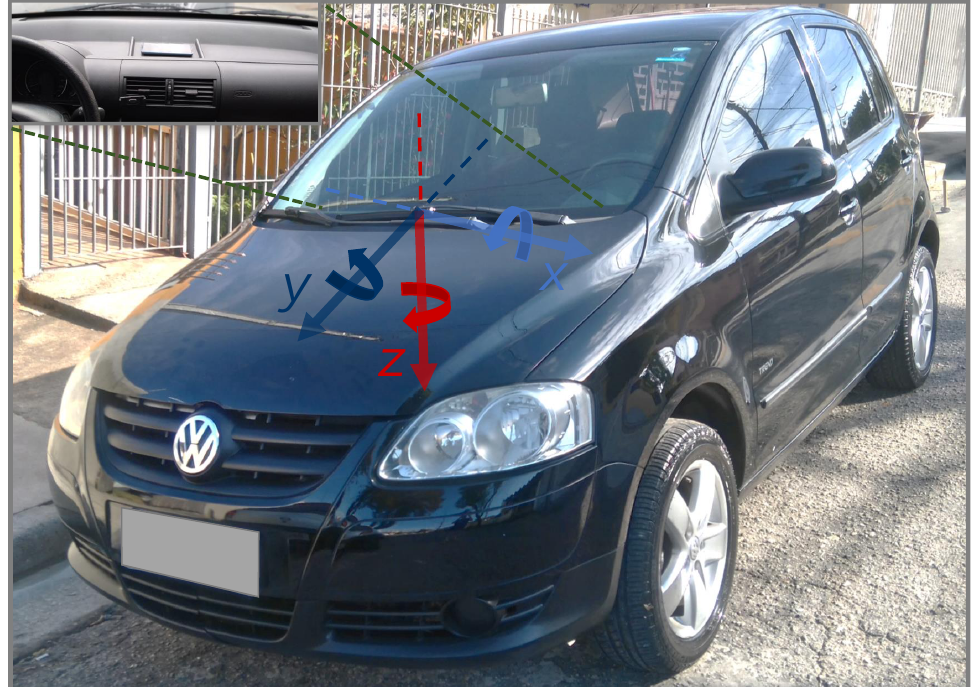
Figure 1. Smartphone installation location (in detail) and coordinate reference system x , y , and z . The x axis points to left and is perpendicular to the vehicle plane of symmetry. The y axis points forward and is parallel to the vehicle plane of symmetry. The z axis extends downwards. The pitch, roll, and yaw are the counterclockwise (right-handed) rotations about the x , y , and z axes,